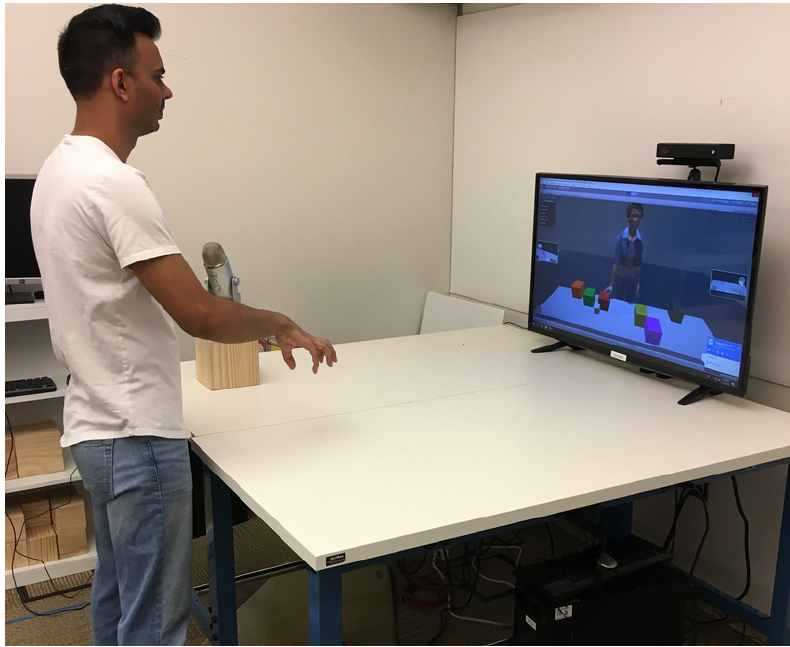
Figure 1. Lab setup used the Kinect v2 sensor for training (Reprinted with permission from J.R. Beveridge, et al. (2019). 2019 IEEE 9th Annual Computing and Communication Workshop and Conference (CCWC)